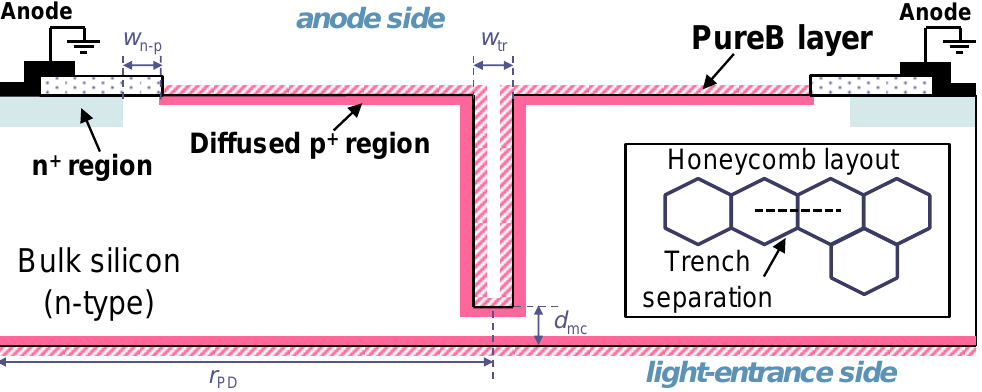
Figure 11. Cross section through two TDD cells of a one-trench multi-cell drift-detector array. The position of the cross section is indicated by the dashed line in the inset showing a top view of a honeycomb-like cell arrangement.